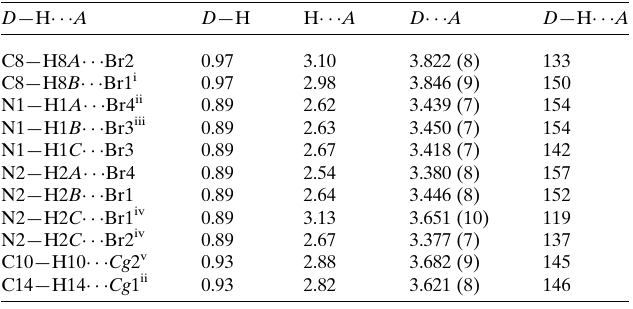
Table 1 Hydrogen-bond geometry (A˚ , (cid:5) ). Cg 1 and Cg 2 are the centroids of the C1–C6 and C9–C14 benzene rings, respectively.